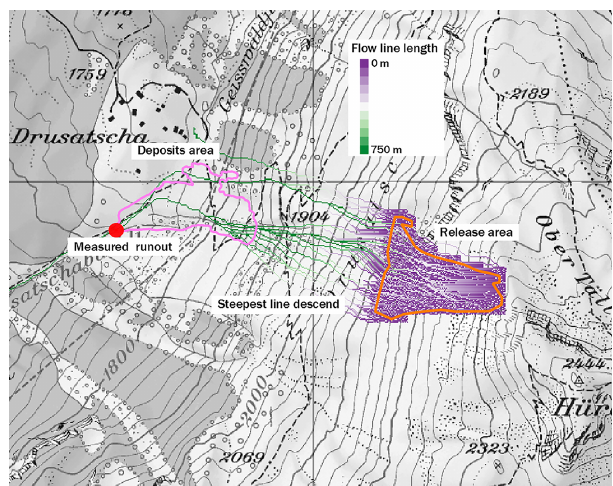
Figure 3. Runout distance calculation procedure. From each calcu- lation cell at the release area the line of steepest descent is calcu- lated. The intersection of the lowest part of the avalanche deposits with the longest calculated flow line (red dot) define the avalanche runout. The same procedure is repeated with the simulation results. The distance measured on the steepest line between the two inter- section points is defined as the runout calculation error.